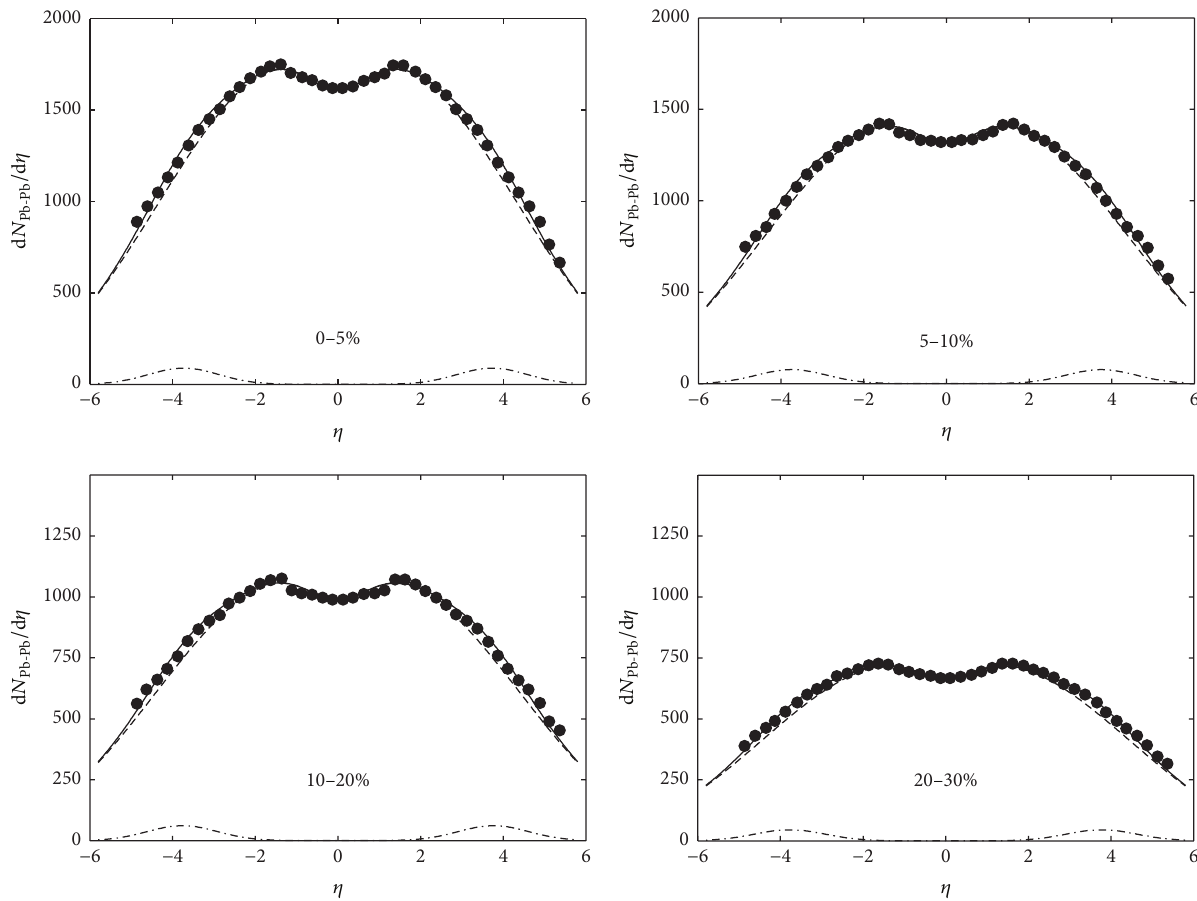
Figure 2: The pseudorapidity distributions of produced charged particles in different centrality Pb-Pb collisions at √𝑠 NN = 2.76 TeV. The solid dots are the experimental measurements [37]. The dashed curves are the results from unified hydrodynamics of (19). The dashed-dotted curves are the results from leading particles of (20). The solid curves are the sums of dashed and dashed-dotted curves.